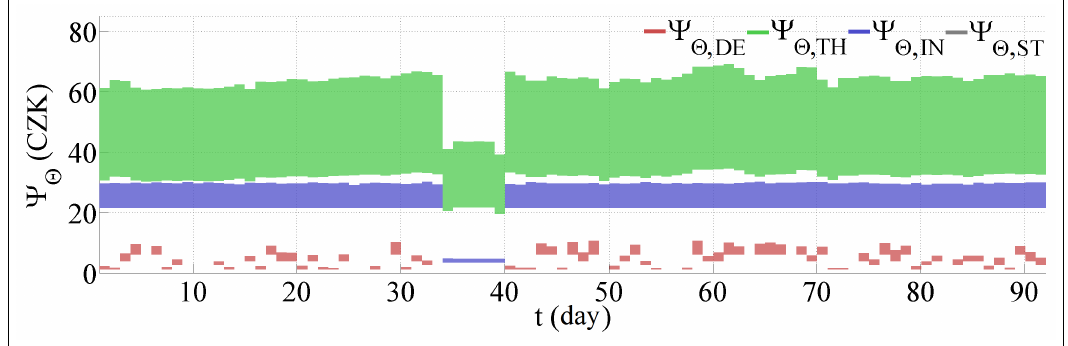
Figure 5. The minimal and maximal values of Ψ Θ for all types of appliances.